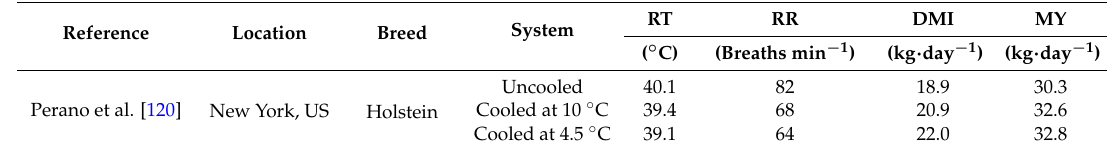
Table 11. Physiological response of dairy cows for a barn equipped with waterbeds at different water